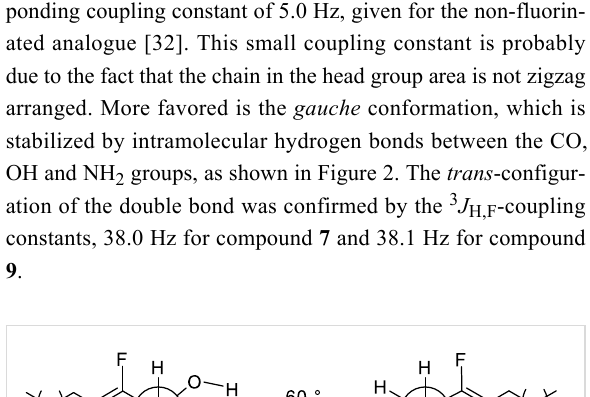
The crude product mixture of the hydrolysis was used in the following reduction without purification. The reduction with